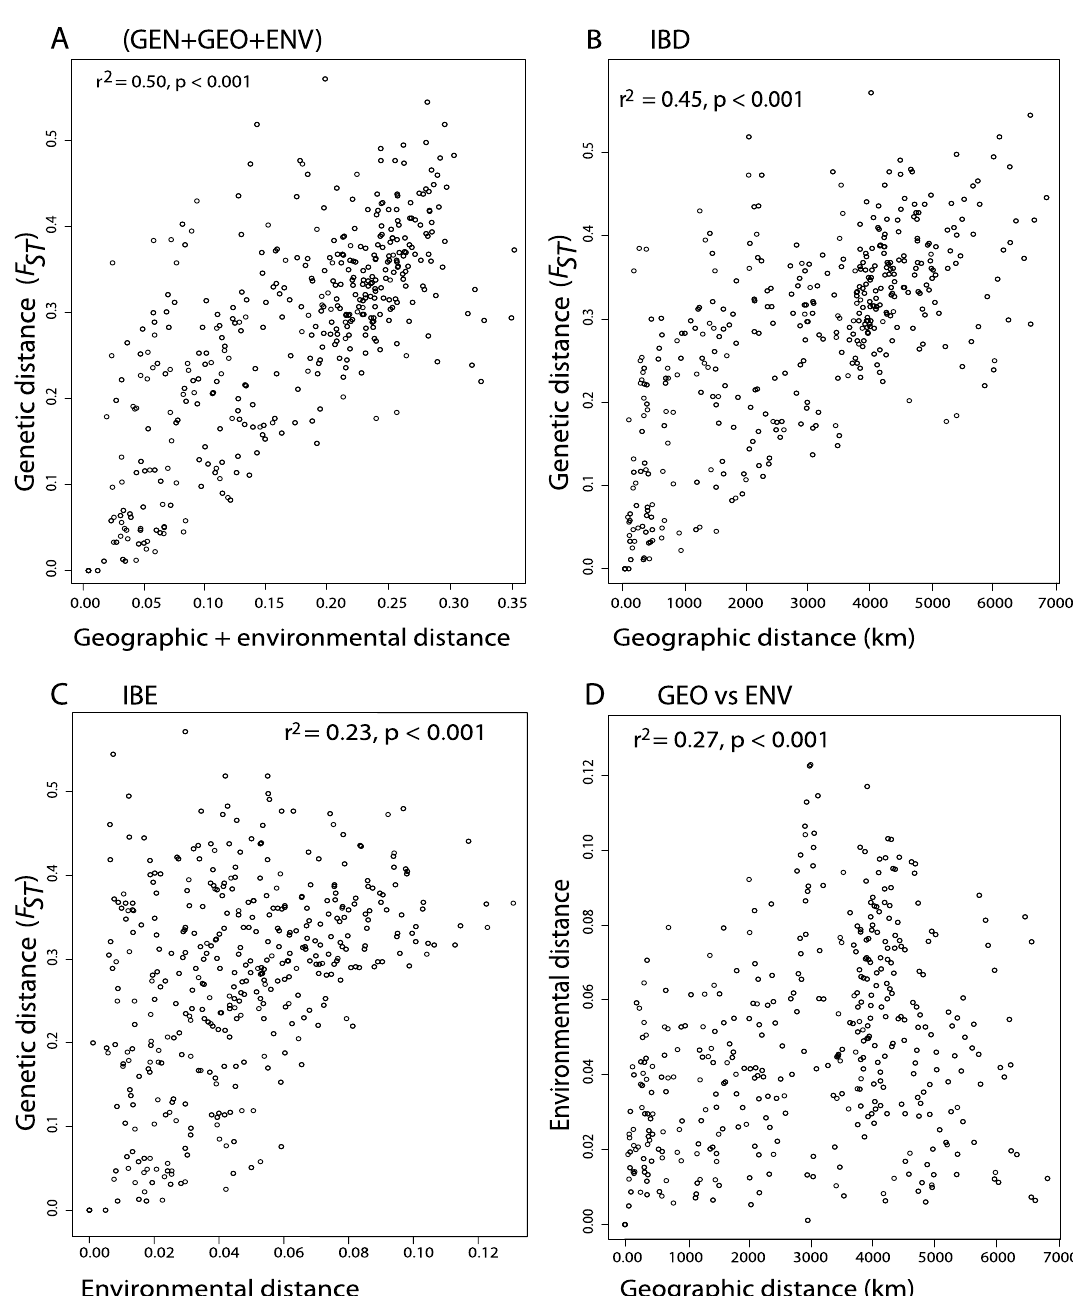
Figure 4. Multiple matrix regression with randomization analysis on Senegalia senegal in Africa. Scatterplots show patterns of ( A ) the combined effects of geographic and environmental distances on genetic distance; ( B ) Isolation by distance; ( C ) Isolation by environment; ( D ) the relationship between geographic and environmental